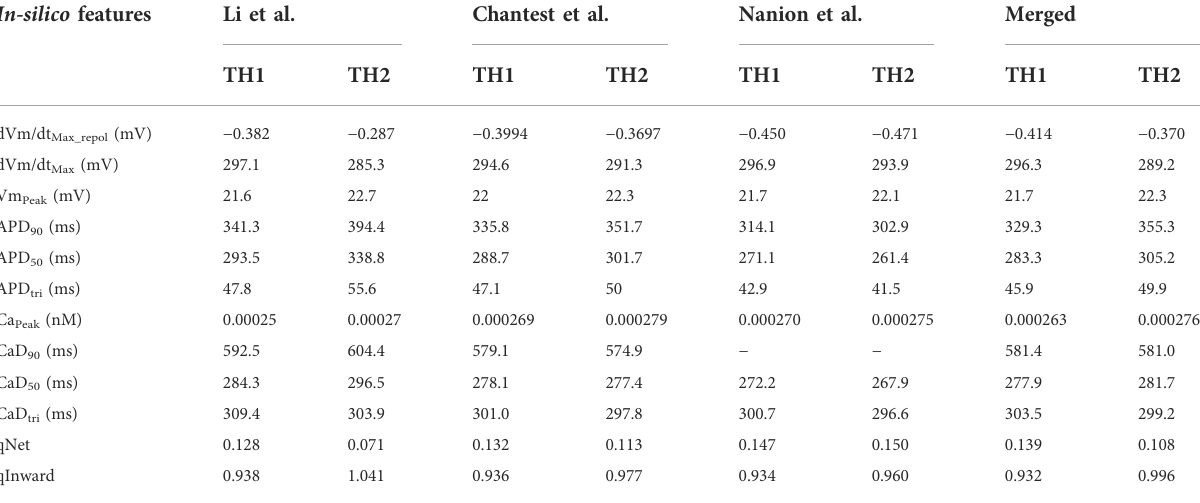
TABLE 2 Thresholds of 12 in silico biomarkers for classifying TdP risk. Threshold 1 (TH1) was used to distinguish the low-risk from the intermediate/ high-risk groups, whilethreshold2 (TH2) was used todistinguish the high-risk from thelow/intermediate-risk groups. Merged, the combinedset containing all three